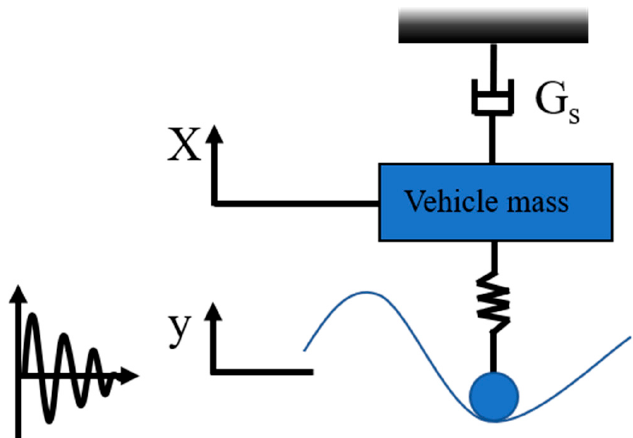
Figure 4. Skyhook controller concept [26]. Reproduced with permission from Choi, S.-B. et al. State of the art of control schemes for smart systems featuring magnetorheological materials; published by Smart Materials and Structures, 2016.